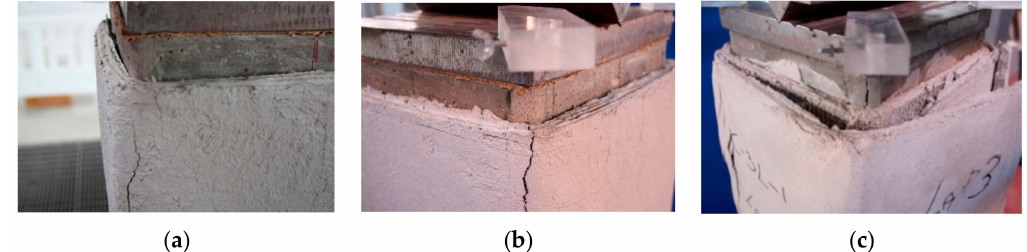
Figure 12. Details of the specimen’s failure: ( a ) detachment in the C-P-2-0 specimen; ( b ) detachment in the C-P-3-0 specimen; ( c ) detachment of the steel grid in the C-S-3-0 specimen.